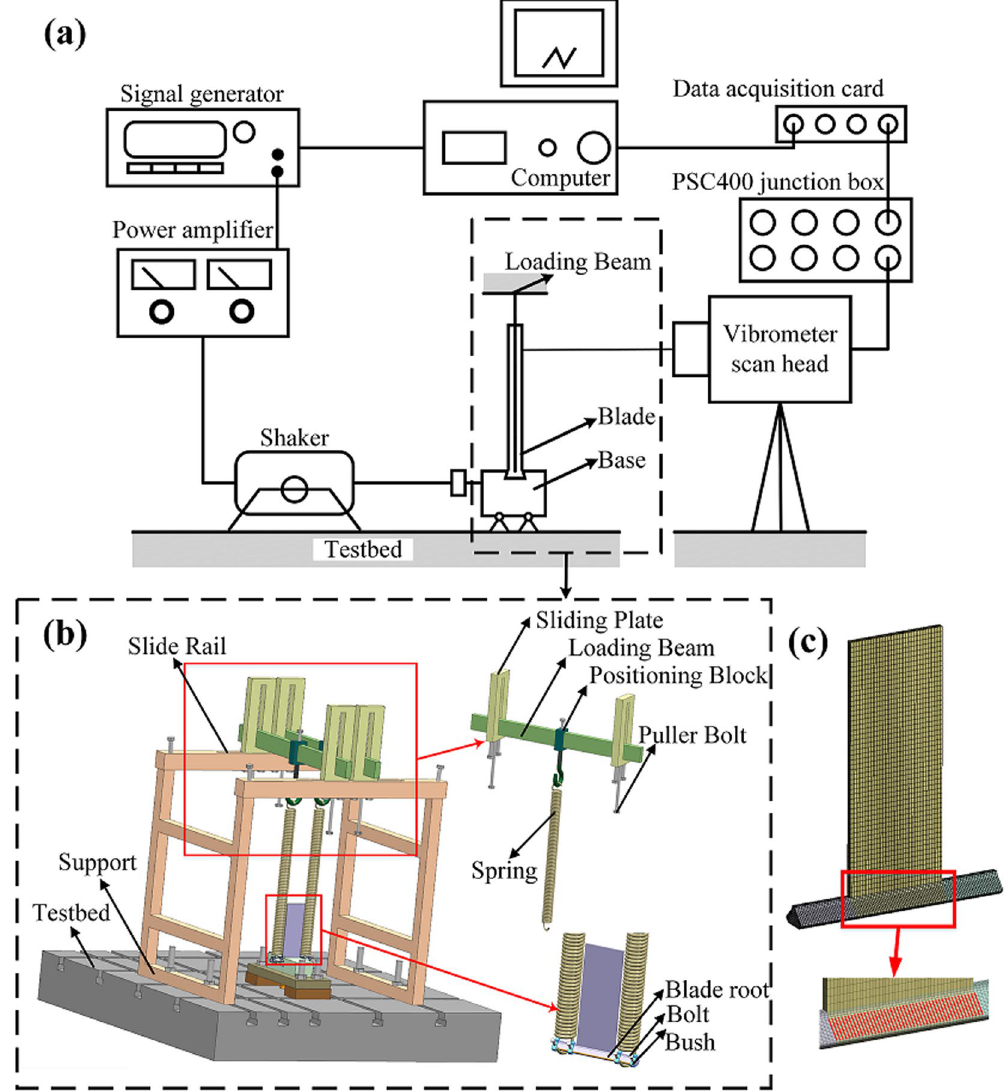
Figure 5. ( a ) Sketch of the measurement system, ( b ) the loading device to tune the normal contact load on the dovetail joint, and (c) the finite element model of the